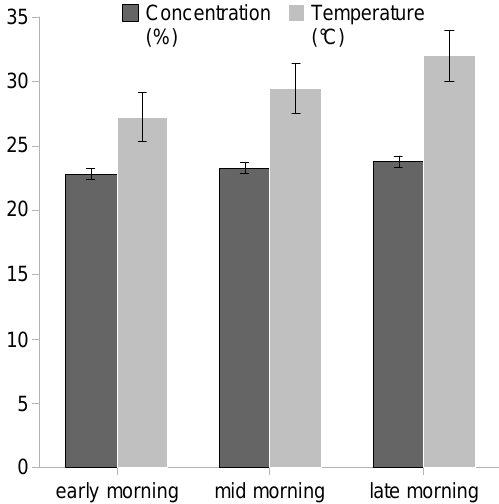
F IG . 2. Temperature (ºC) and nectar concentration (%) of A. comosus at different times of the day. Error bars represent 2